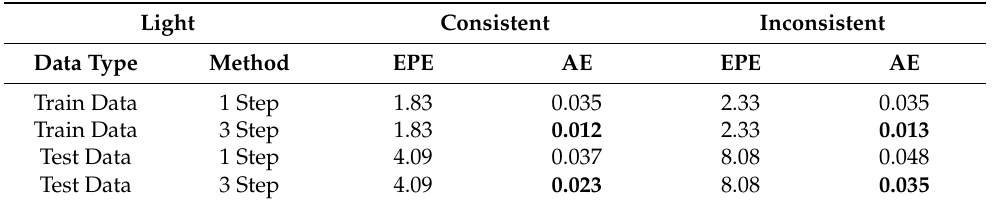
Table 1. Quantitative comparison of the 1 Step and the proposed 3 Step methods to predict the pose from given warped vertex and normal maps.